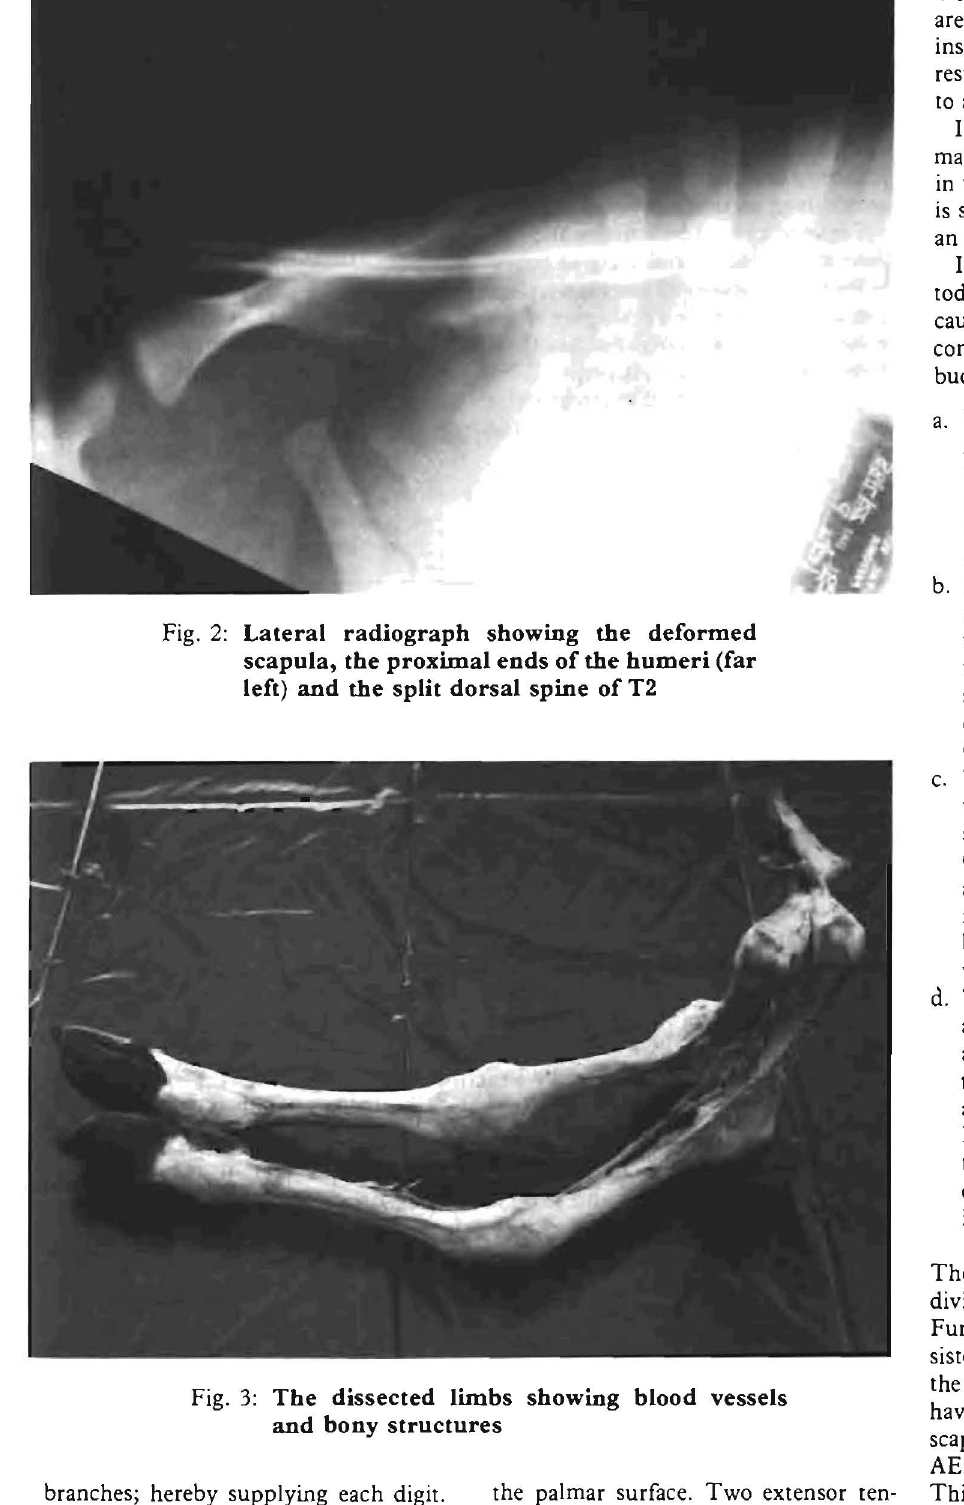
Fig. 3: The dissected limbs showing blood vessels and bony structures branches; hereby supplying each